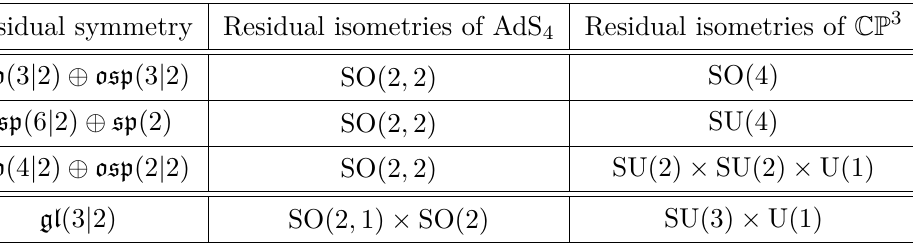
Table 6 . Possible crosscaps in the AdS 4 / CFT 3